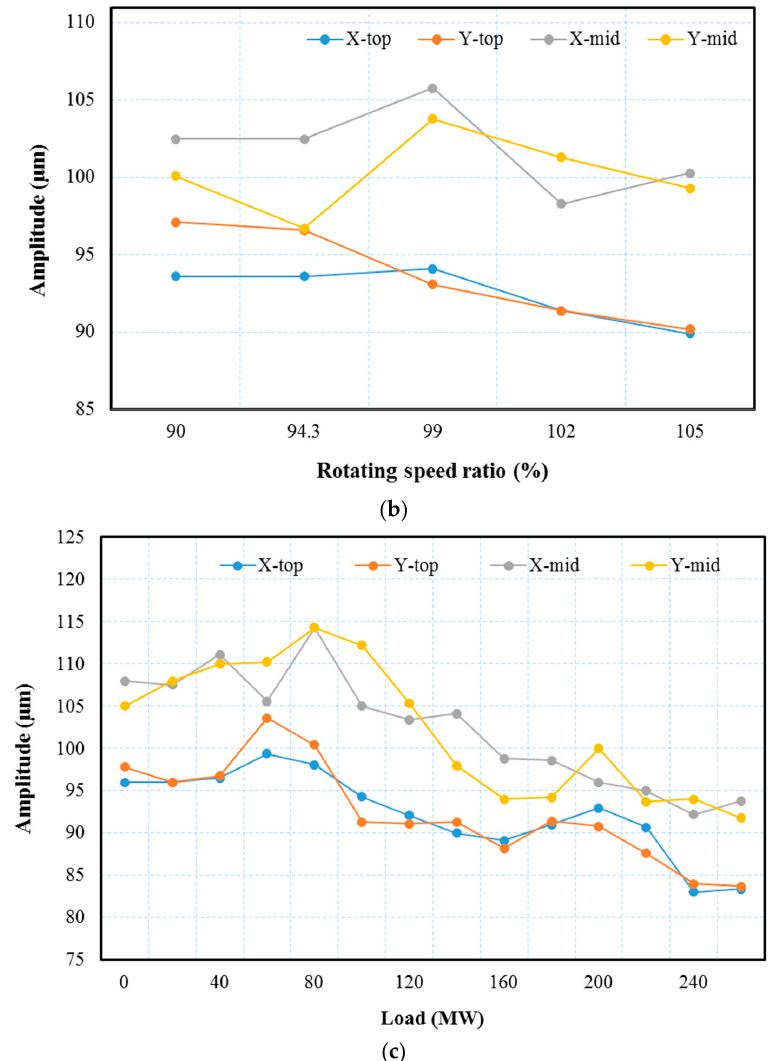
Figure 4. Vibration peak value of stator frame of experimental tests: ( a ) excitation test at no-load and rated speed condition; ( b ) rotation speed test at no-load and 100% excitation condition; and ( c ) load test at rated speed and 100% excitation condition.